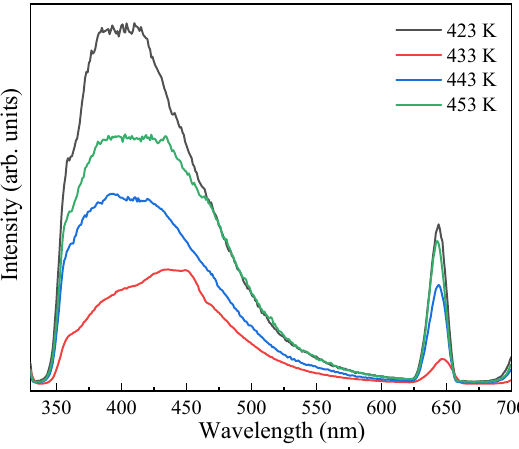
adsorption-photocatalytic efficiency of MnS declined with the climbing TCH concentra- Figure 5. PL spectra of MnS treated at different temperatures. Figure 5. PL spectra of MnS treated at different temperatures. tion ranging from 220 to 280 mg L − 1 .